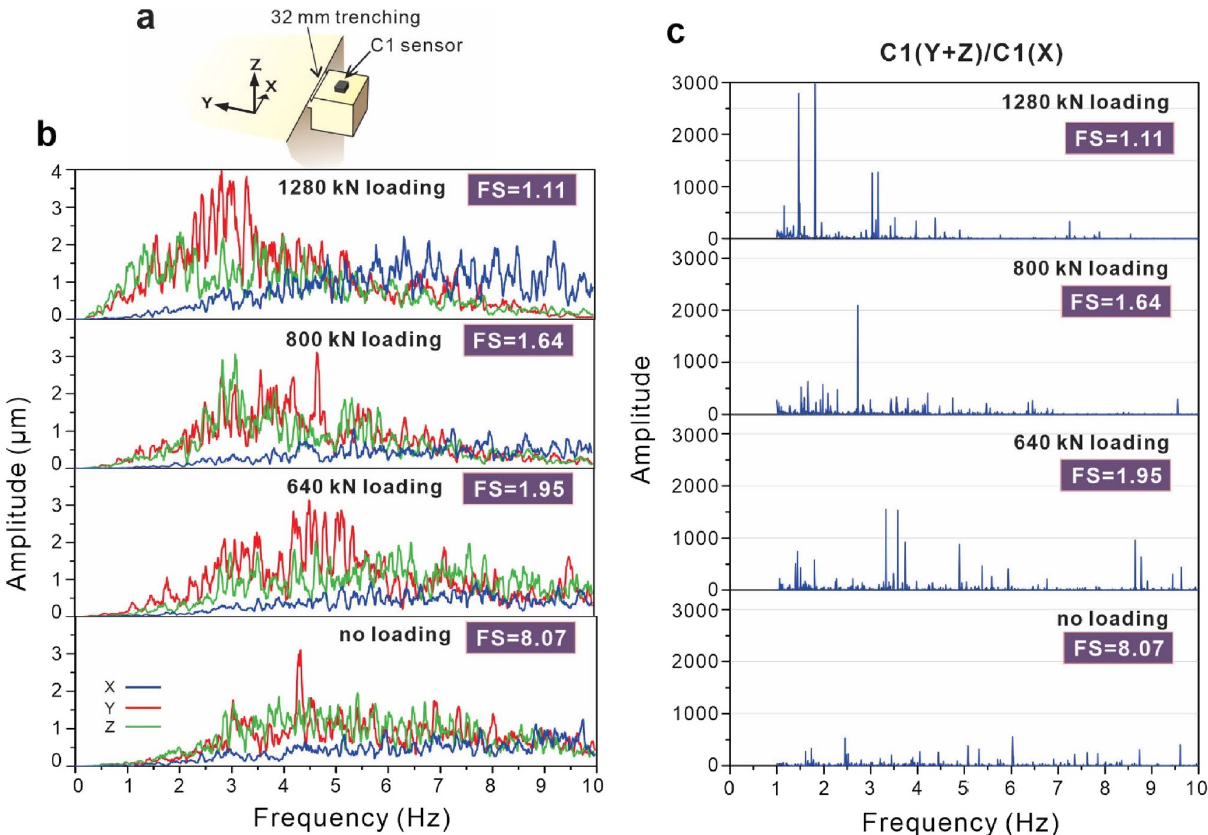
Figure 4. Measured and feature extracted microtremor signals of the overhanging block under progressive loading. ( a ) Schematic diagram of the overhanging specimen including a 32 mm-deep upper trench. ( b ) Measured microtremor signals, decomposed into three components, of the overhanging block under progressive loading. ( c ) Feature extracted microtremor signals. The result from the sum of the horizontal components towards the main block (y-axis) and the vertical component (z-axis) together, divided by the horizontal tangential component, towards the